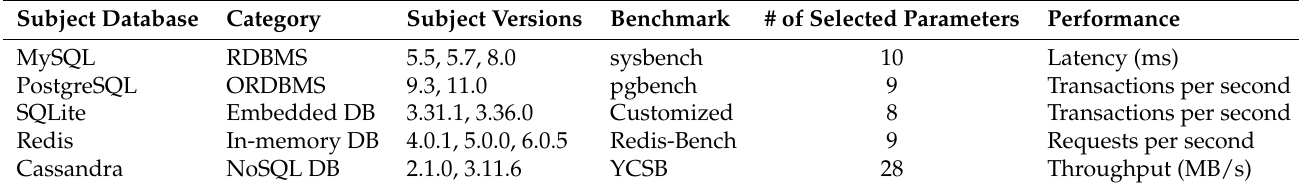
Table 1. Subject databases and versions, benchmarks, parameters, and performance